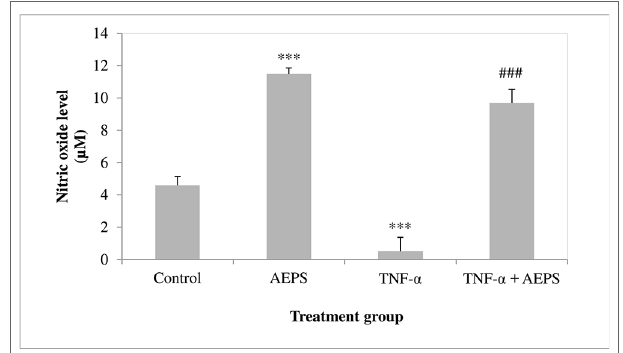
FIGURE 5 | Dimethylarginine dimethylaminohydrolase (DDAH) enzyme activity in human umbilical vein endothelial cells (HUVEC). Data shown as mean ± SEM, n = 6 [* P < 0.05 compared with the control group, # P < 0.05 compared with the tumor necrosis factor (TNF)- α group].